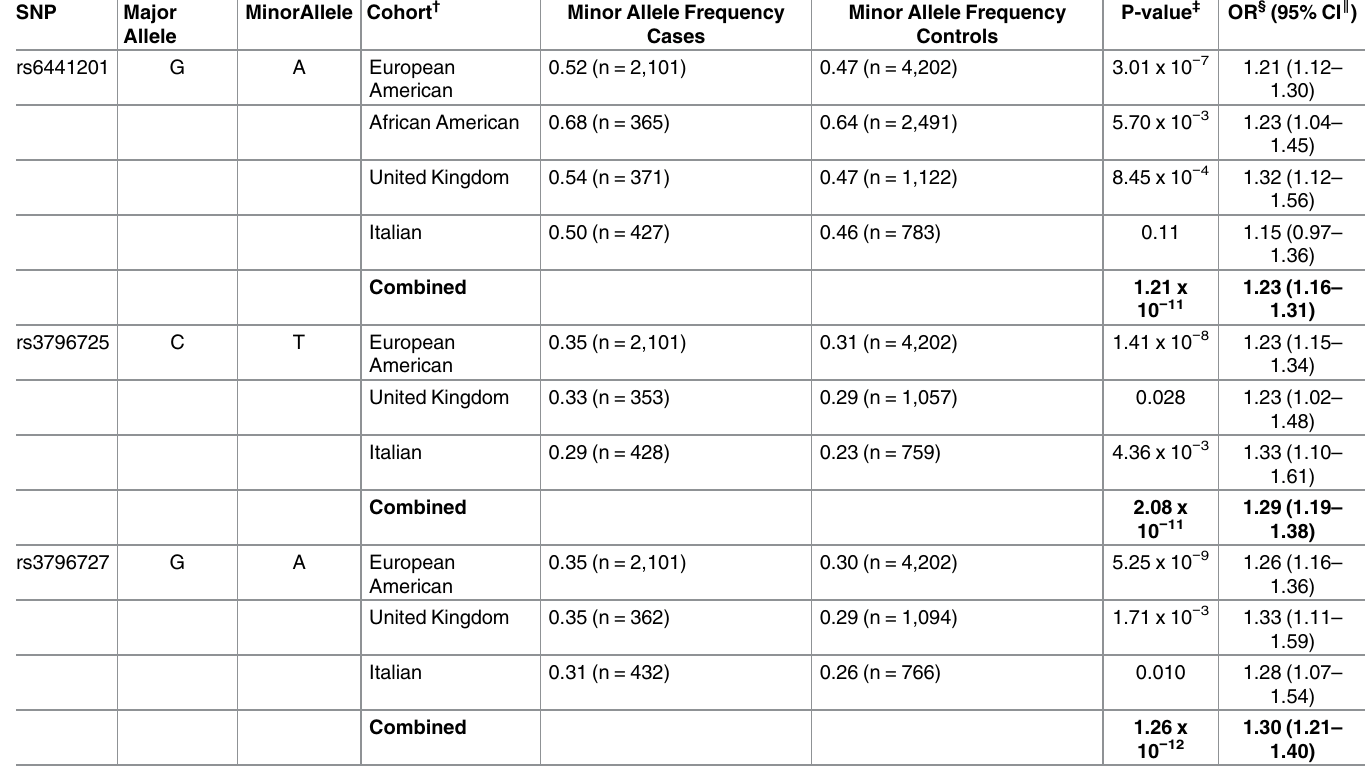
Table 1. Statistically significant and replicated SNP associations at 3q25 and